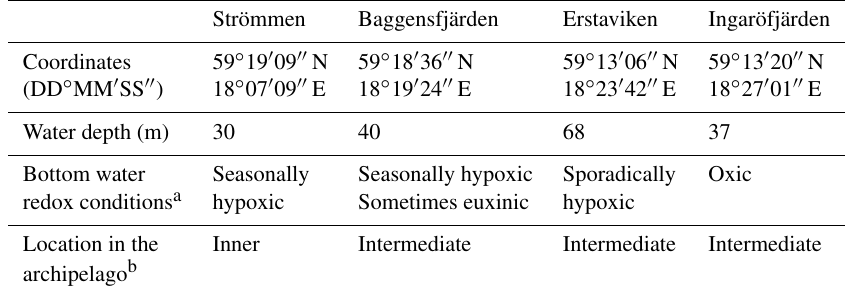
Figure 3. Bottom water dissolved oxygen plotted against total P, with the black line depicting the inverse linear relationship between the two (a) and total N / total P (b) for the water quality monitoring stations (SMHI, 2019; Fig. 1) most proximate to the study sites. Bottom water dissolved oxygen and bottom water P (c) and N (d) for Baggensfjärden from 2013 until 2017. The dashed red line (located at 1.4mLL − 1 ) indicates the hypoxic boundary in all panels. Table 1. General study site